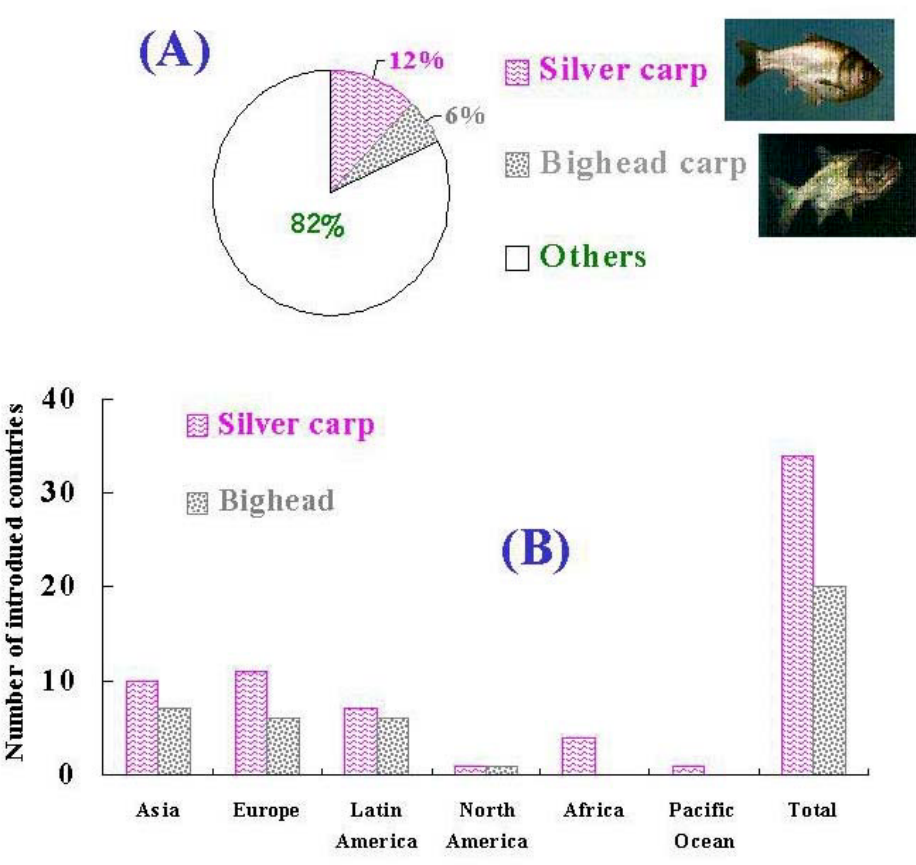
FIGURE 15. (A) Proportions of silver carp and bighead in the world's total catch of inland waters in 1989 (data from FAO[49]), and (B) a summary of introduction of silver carp and bighead carp in the world (data from